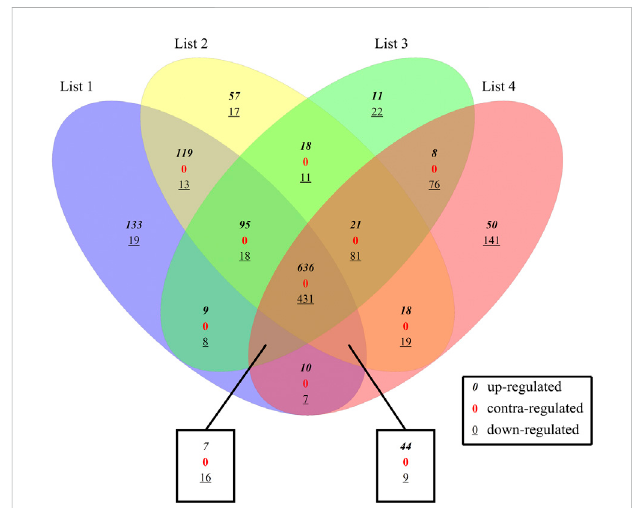
FIGURE 2 Comparison between 4 DE sets. List1: S1 and Normal, List2: S2 and Normal, List3: S3 and Normal, List4: S4 and Normal; where 0 indicates up-regulatedgenes,0 representsdown-regulated genesand 0denotes contra-regulated genes (however there are no contra-regulated